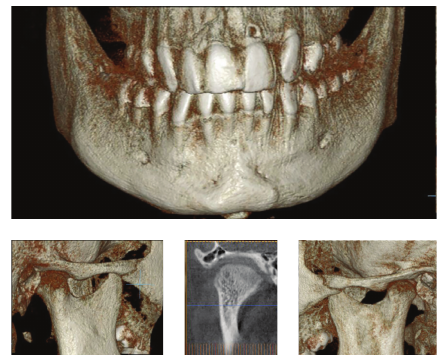
Figure 7: Cone beam CT views of the mandible after 18 months.